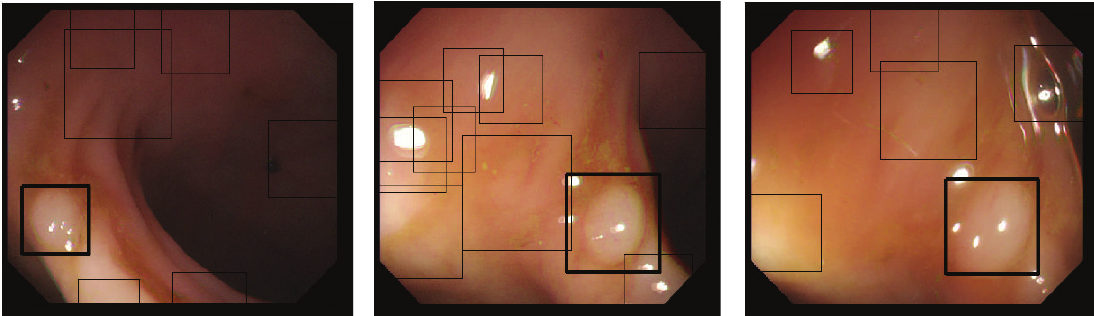
Figure 3: Three examples of the proposed boosting-based polyp detection approach in [2].